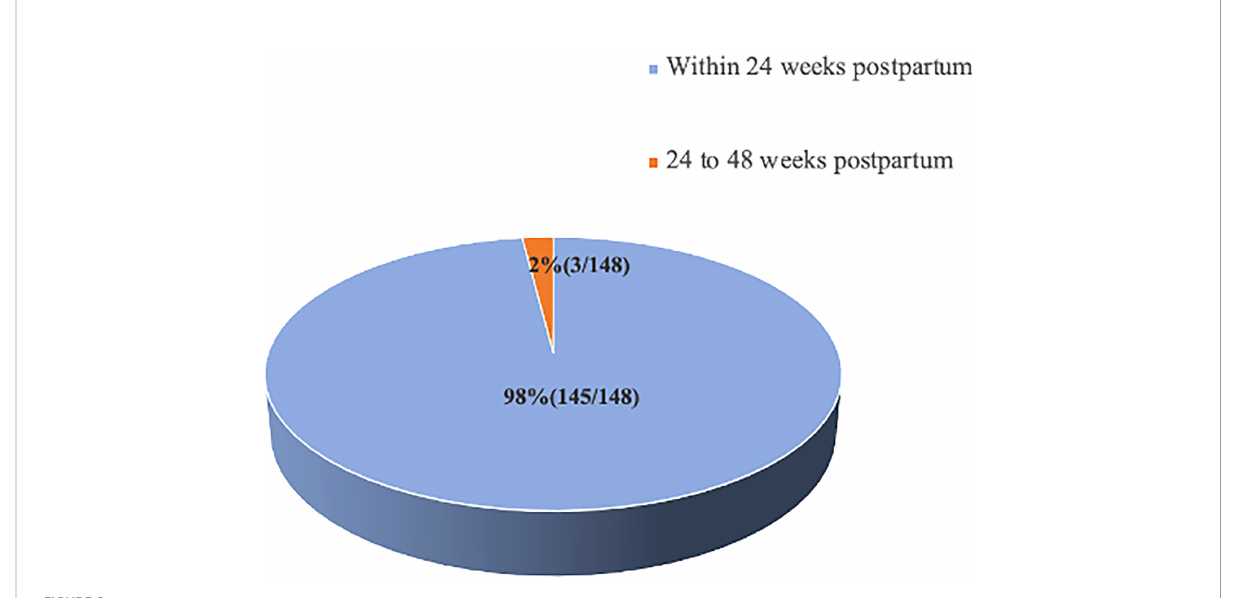
FIGURE 2 Distribution of postpartum hepatitis fl